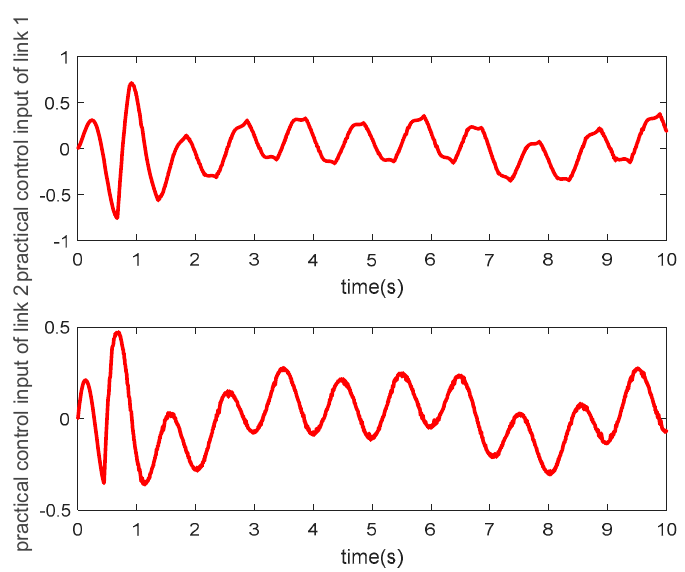
Figure 15. Control input of joints 1 and 2 after adopting the intelligent control scheme.